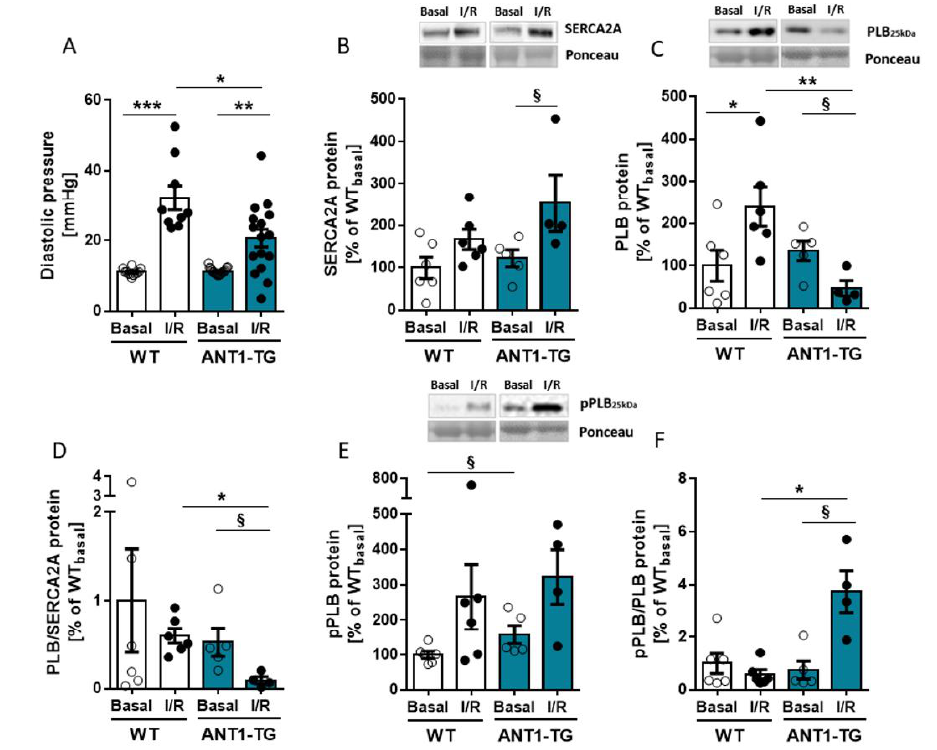
Figure 5. Diastolic pressure and calcium-handling proteins. ( A ) Diastolic pressure (P dia ) of WT and ANT1-TG hearts. Data are shown for the pre-ischemic stabilization phase (Basal) and after 120 min of reperfusion (I/R) (WT, n = 10 – 12; ANT1-TG, n = 16 – 19). WT and ANT1-TG mitochondria were isolated after 15 min of basal perfusion (Basal) or after 45 min of ischemia, followed by two hours of reperfusion (I/R), and protein extracts were prepared. Figures show the ( B ) SERCA2a ( C ), PLB, ( D ) the PLB/SERCA2a ratio, ( E ) phosphorylated PLB (pPLB), and ( F ) the pPLB/PLB ratio, as assessed by Western blot quantification. Upper panels of graphs ( B , C , E ) show representative Western blots. Data are presented as the mean ± SEM from four to six heart preparations. Asterisks indicate significant differences * p < 0.05, ** p < 0.01, *** p < 0.001 using one-way ANOVA or Kruskal – Wallis with the respective post hoc tests or § p < 0.05 calculated using the Mann – Whitney U test.